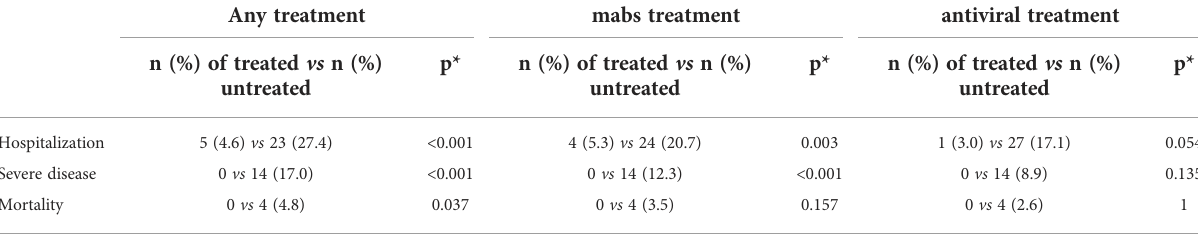
TABLE 3 Impact of treatment with mabs and antivirals on hospitalization, severity of disease and mortality.